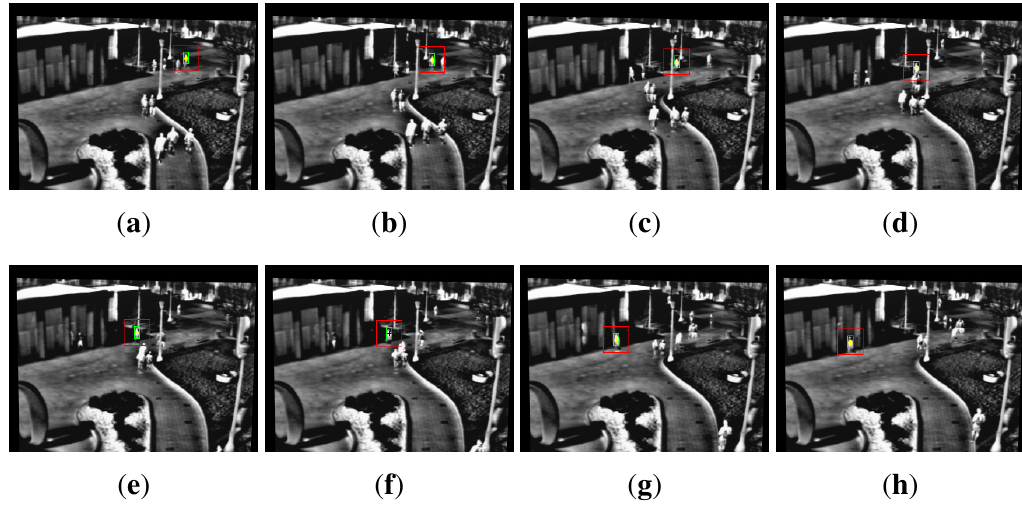
Figure 4. Tracking results with the ATT algorithm for sequence otcbvs 03-l1s1ir-12. ( a ) Frame 142; ( b ) Frame 188; ( c ) Frame 249; ( d ) Frame 333; ( e ) Frame 391; ( f ) Frame 407; ( g ) Frame 498; ( h ) Frame